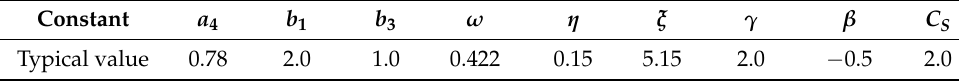
Table 4. Model constants and typical value in the G-equation model. Constant a